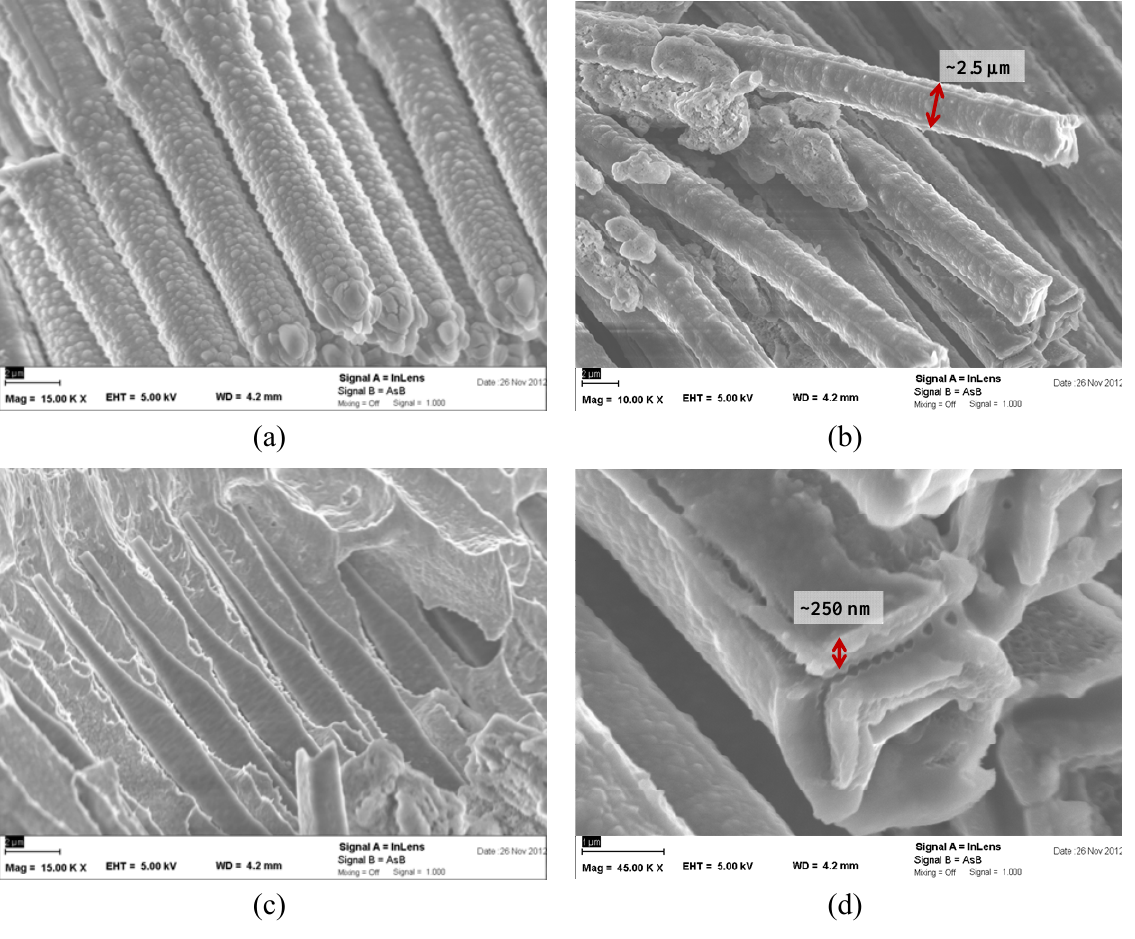
Figure 4. Micrographs of different regions of the same lithiated microwires as shown in Figure 3. ( a ) Tips of the wires; ( b ) Middle section; ( c ) Section embedded in Cu; ( d ) Surface of the wires in the middle section; here the solid electrolyte interface (SEI) is